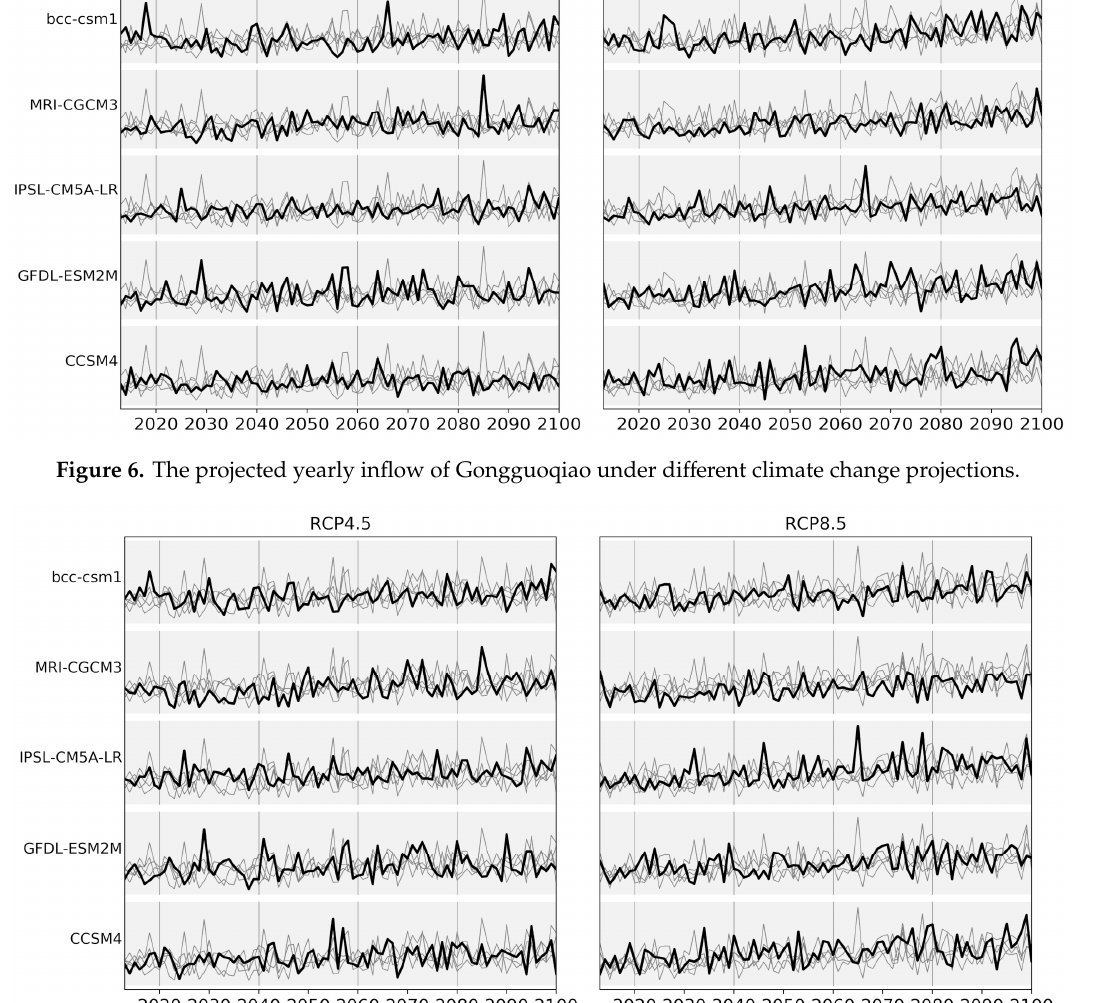
Figure 7. The projected yearly inflow of Liyuan under different climate change projections.